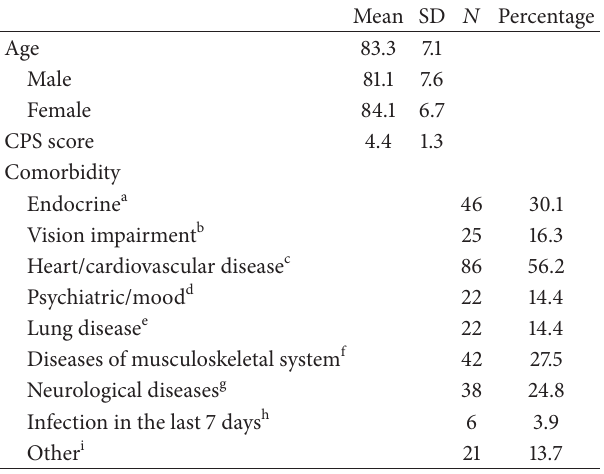
Table 1: Descriptive and demographic data of subjects ( 𝑁 = 153